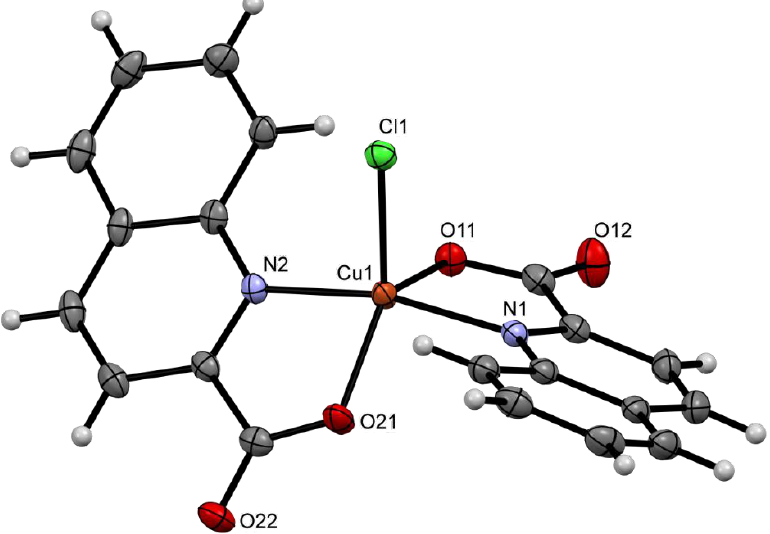
Figure 7. ORTEP drawing of [Cu(quin) 2 Cl] − , a complex anion of 3 . Displacement ellipsoids are drawn at the 50% probability level. Hydrogen atoms are shown as spheres of arbitrary radii.